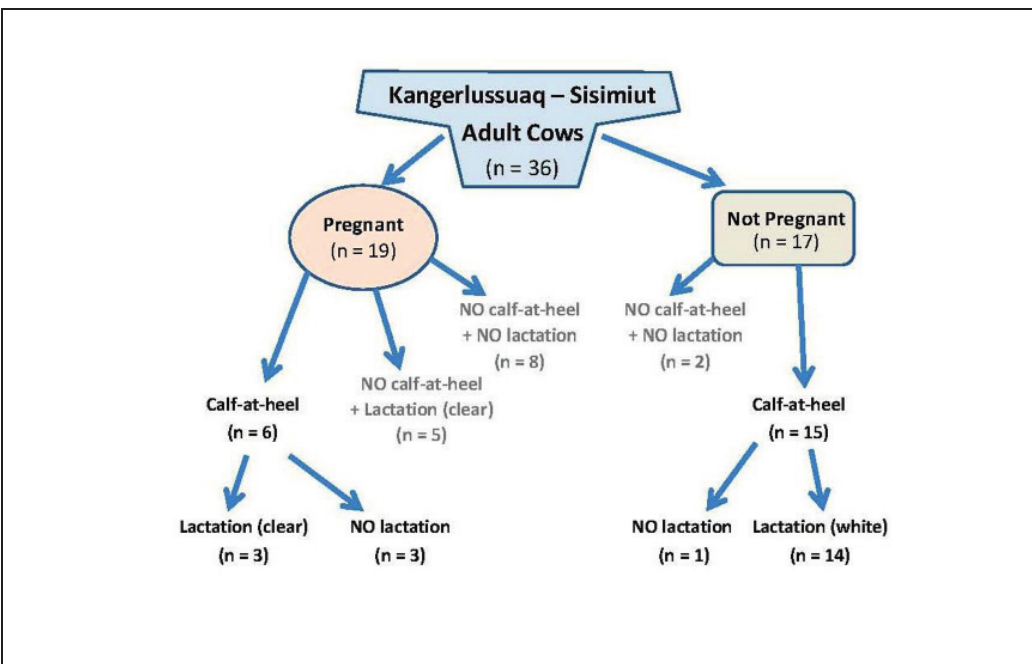
Fig. 3. Reproductive status among the adult cows from the Kangerlussuaq-Sisimiut caribou herd of West Greenland collected from 3 to 17 March